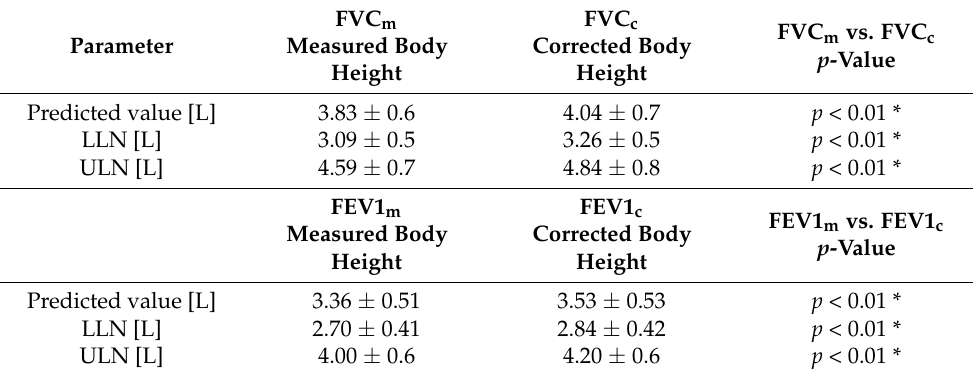
Table 2. Predicted values of the pulmonary parameters calculated (GLI 2012, [17]) for the measured versus the corrected body height, N = 120.